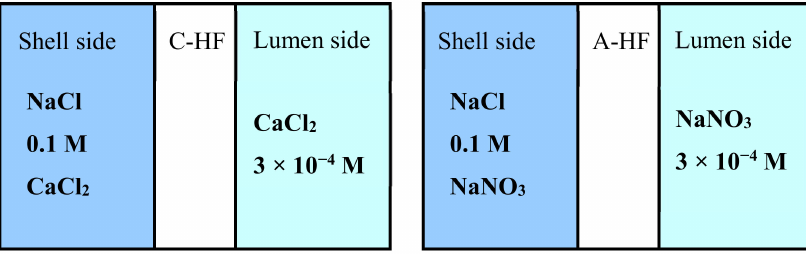
Figure 6. Schematic diagram of Donnan dialysis systems using the C-HF membrane and the A-HF